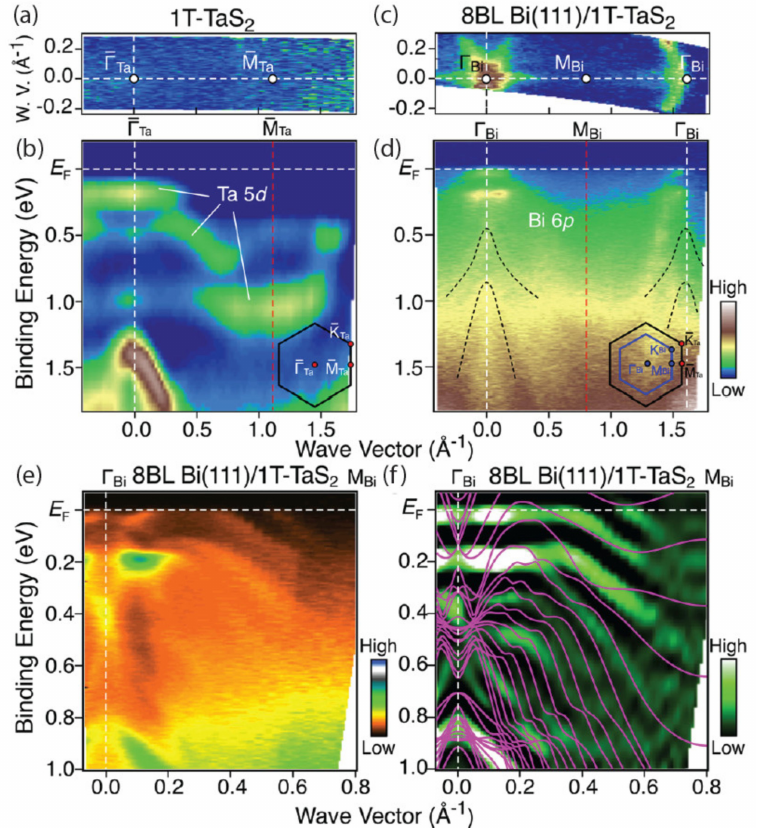
Figure 16. ( a ) Plot of ARPES intensity at the Fermi energy is shown for pristine 1 T -TaS 2 as a function of in-plane wave vector. ( b ) ARPES intensity as a function of binding energy. ( c , d ) Show the same content as ( a , b ) but for 8BL Bi(111) on 1 T -TaS 2 . ( e , f ) Shows ARPES data and their second derivative intensities, respectively, for 8BL Bi(111)/1 T -TaS 2 as a function of binding energy and wave vector. Solid curves in ( f ) are calculated band dispersions for free-standing 8BL Bi(111). The ARPES data were recorded at 30 K. Reprinted with permission from Reference [152]. Copyright 2018 by the American Chemical